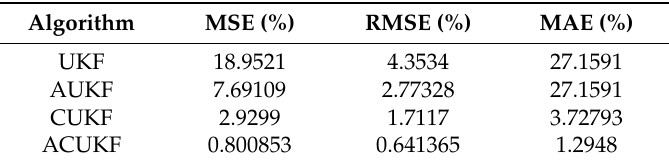
Table 3. Evaluation results for different SOC estimation Table.3 Evaluation results for different SOC estimation methods.